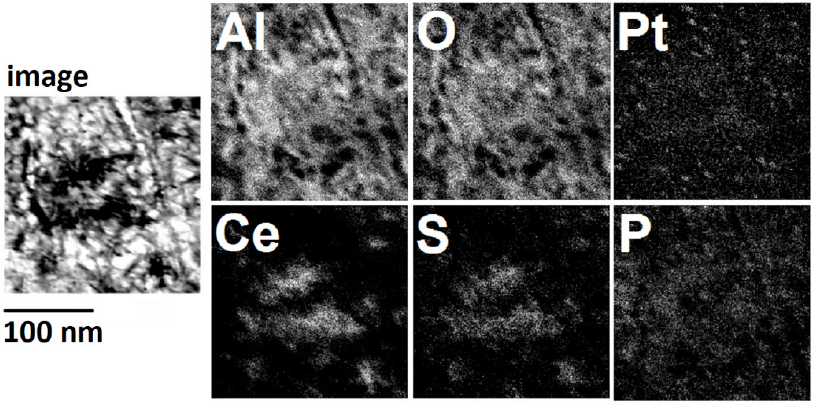
Figure 6. Cross-sectional TEM–EDS map from the vehicle-aged diesel (inlet) catalyst.